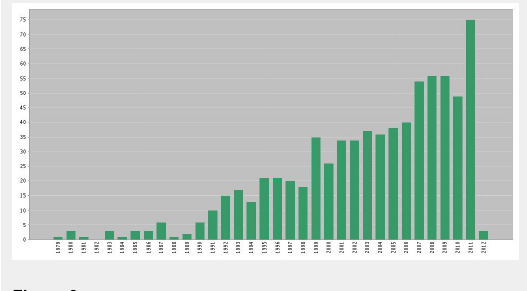
Referenced publications on ICU elderly patients’ outcomes. Data extracted from ISI Web of science, Web of Knowledge (2012). Key words: (“intensive care” OR “critical care” OR “icu”) AND elderly AND outcome. Results: 1,048